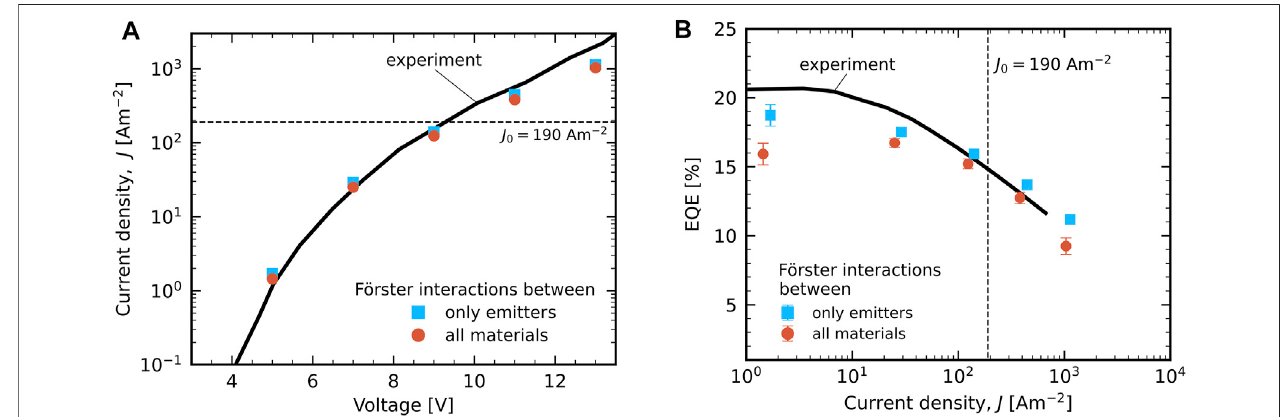
FIGURE 2 | Experimental (full black curves; from Furukawa et al. (2015)) and KMC simulation results of the device in its pristine state, considering Förster-type processesonlybetweensitesoftheemittermaterial(bluesquares)orbetweenallmaterials(redspheres). (A) J ( V )characteristics. (B) theEQEroll-off η EQE ( J ),assuminga light outcoupling ef fi ciency of 25%. In both panels the current density at which the degradation simulations are performed, J 0 (cid:2) 190 Am − 2 , is indicated by a dashed line.